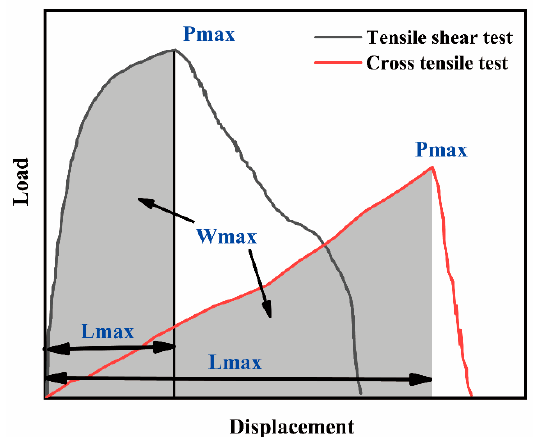
Figure 7. Typical load–displacement curves for the tensile shear and cross-tensile tests.